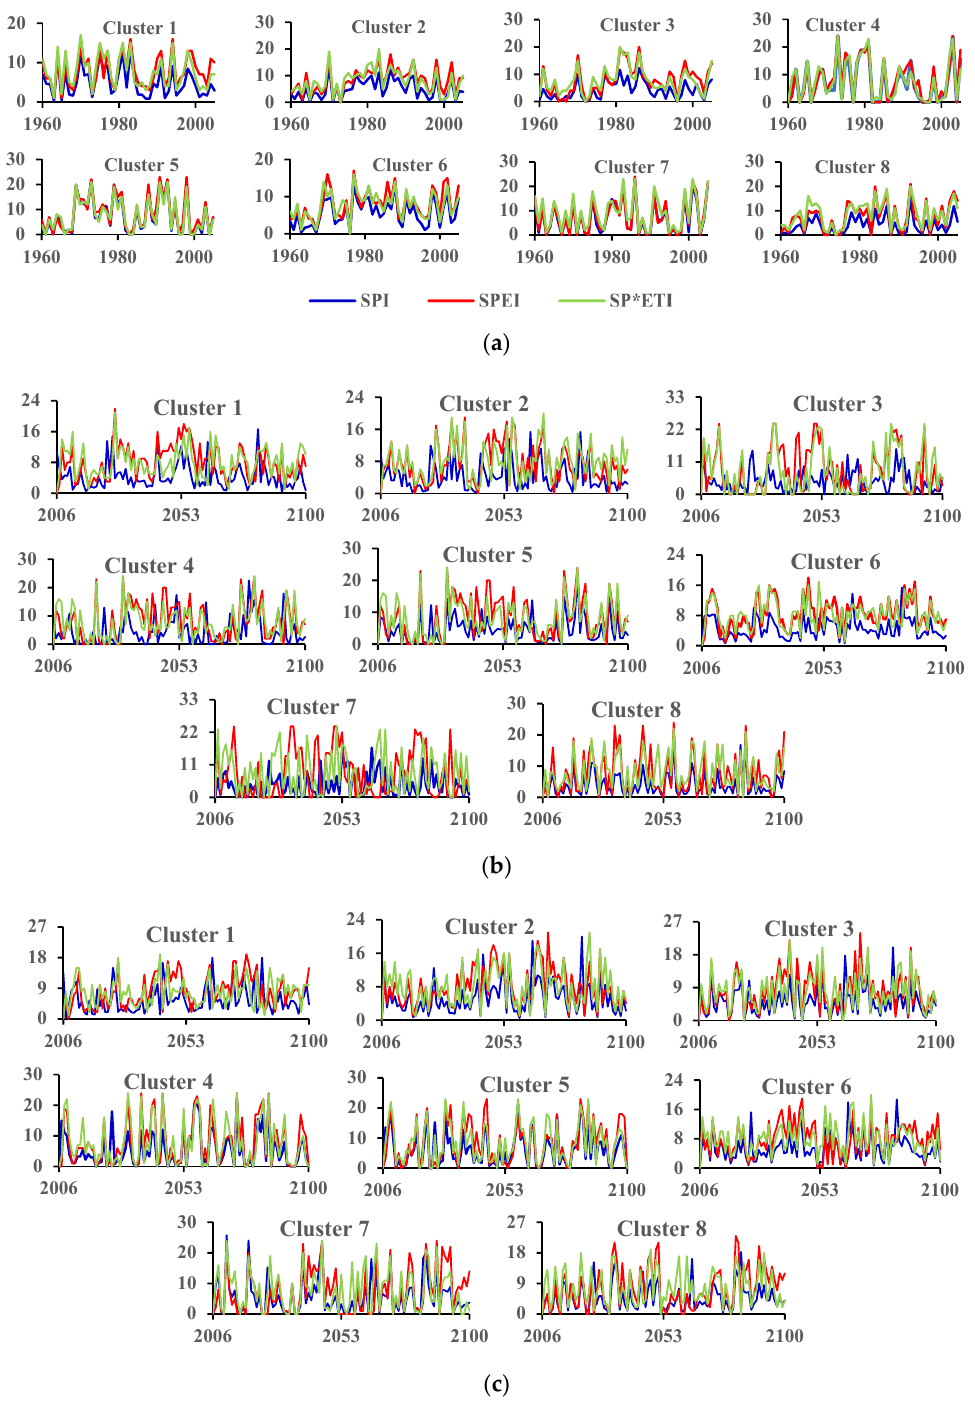
Figure 9. ( a ) The variations in drought area for different clusters with time over Hist. Blue line represents SPI data, and the red line represents SPEI data, and the green line represents SP*ETI data. ( b ) The variations in drought area for different clusters with time under RCP 4.5. ( c ) The variations in drought area for different clusters with time under RCP 8.5.